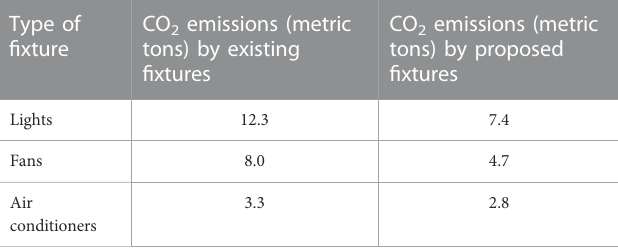
TABLE 4 CO 2 emissions reduced by electrical retro fi